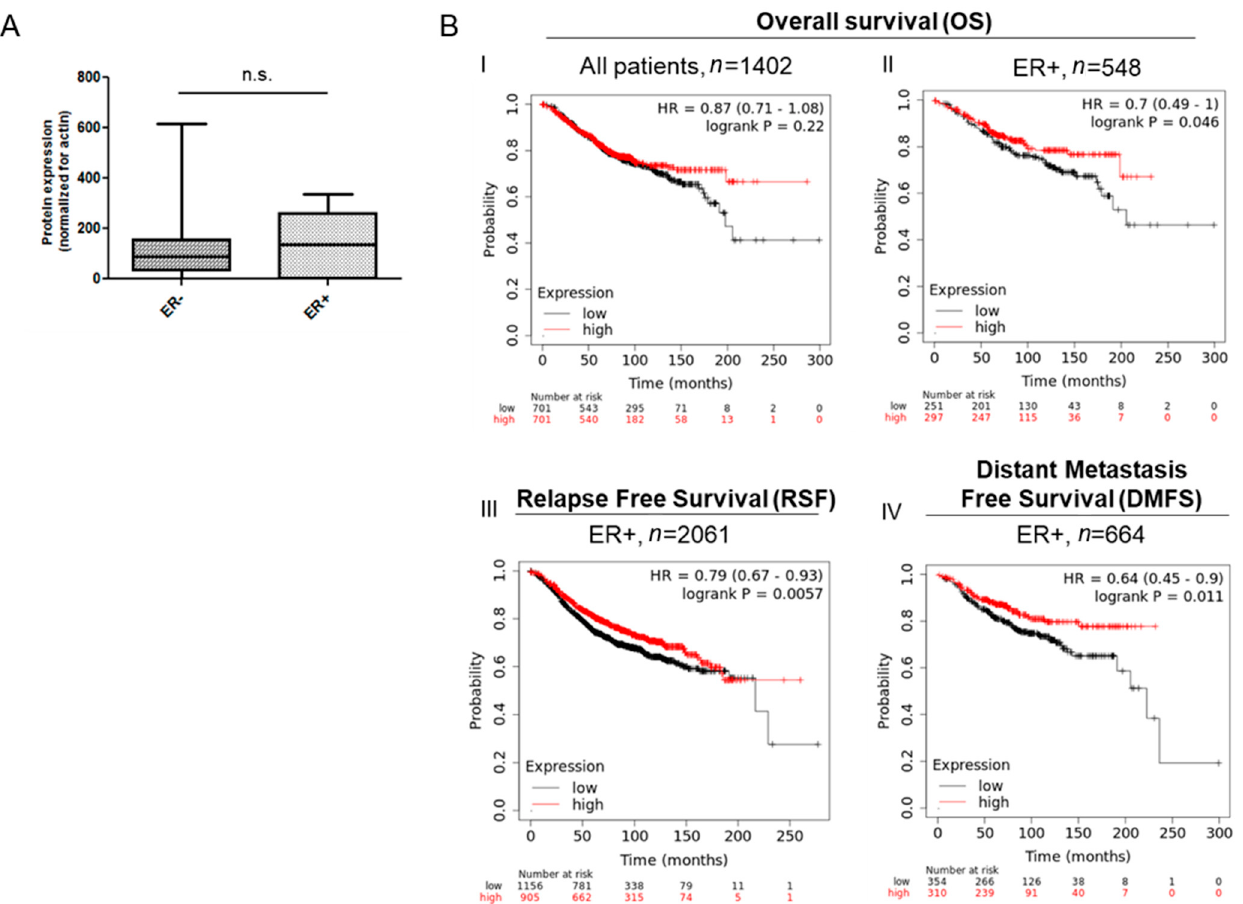
Figure 8. C10orf118 is highly expressed in breast tumour tissues that express ER and its level of expression is correlated with higher overall survival. ( A ) Quantitative analysis of c10orf118 expression normalized to actin as obtained from immunoblot of cancer patient specimens. ( B ) Kaplan-Meier survival plots obtained by http://kmplot.com/analysis/ (accessed date 20 January 2021) to evaluate the overall survival (OS), relapse free survival (RFS) and distant metastasis free survival (DMFS) of breast cancer patients in the database expressing high (red line) and low (black line) levels of the c10orf118 mRNA.